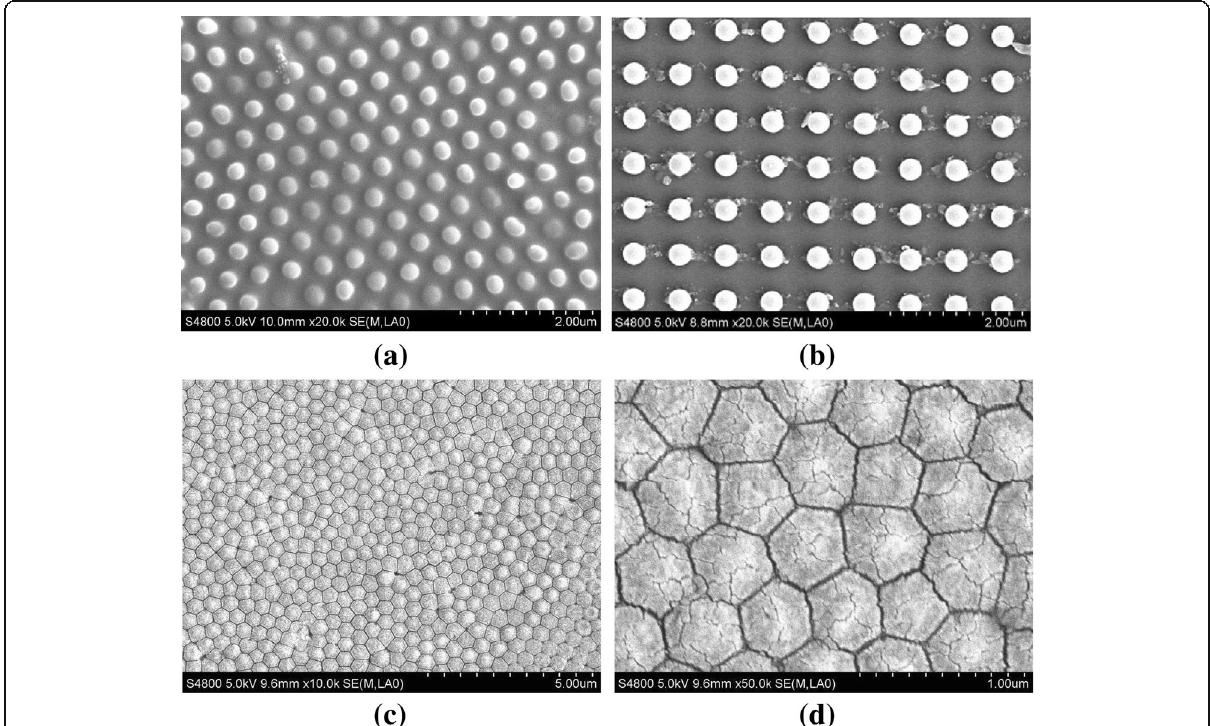
Fig. 5 SEM images of three nanopillar arrays. Random ( a ) and square arrangement ( b ) circular nanopillars, hexagon arrangement and shape nanopillar arrays ( c ), and magnification image of hexagon nanopillars ( d ) are shown